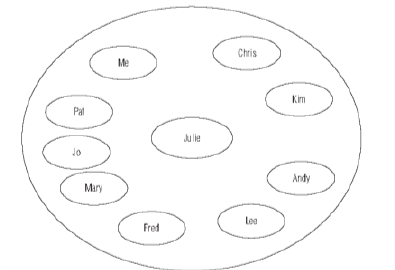
Figure 15: Attached Group Imago (Hay, 2009 p.175) terms of the lines used. As shown in Figure 16, a family that arrives at healthy attachment will mean that its members have healthy group boundaries, shown by a line of dashes. Those growing up in alienated circumstances may have the dotted line that represents lack of a boundary, having not experienced what it feels like to be contained within a family